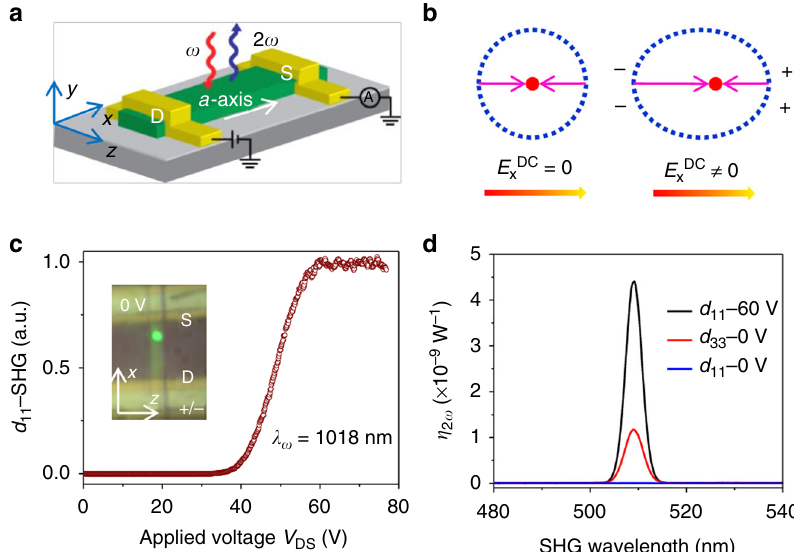
Fig. 1 Field-induced second-order nonlinear coef fi cient ( d 11 ) in a CdS nanobelt. a Schematic of a CdS nanobelt device with the source (S) and drain (D) electrodes. The long-axis of the nanobelt ( x -axis) is determined to be CdS a -axis, which is perpendicular to the z -axis (or CdS c -axis). The fundamental wave at the frequency of ω is normally incident upon the belt and excites the second-harmonic wave at 2 ω which is back-scattered. b Schematic of the response of the electron wave function to a strong d.c. applied fi eld. An atom with a positively charged nucleus (red dot) is surrounded by electron cloud (blue dots). If there is no external electric fi eld, the electron wave function is symmetric along the x -axis, which can be distorted by an external electric fi eld, thus turning on certain fi eld-induced second-order nonlinear coef fi cients. c Voltage-dependence of d 11 -SHG signal. Inset: device image when the fundamental wave (FW) is incident upon the CdS nanobelt near the source electrode (S). The S-electrode is grounded (0 V) and the drain electrode (D) is biased. When applying a positive bias ( V DS > 0), the electric current is along the x -axis (from D-electrode to S-electrode), with the reverse bias on the S- contact ( V DS > 0). d Normalized conversion ef fi ciency ( η 2 ω ¼ P 2 ω = P 2 ω ) of second-harmonic generation (SHG) resulting from different nonlinear coef fi cients ( d 11 and d 33 ) at different applied voltages ( V DS ), 0 and 60 V. In order to detect the d 11 -SHG signal, we focused the FW polarized along the x -axis ( I ω ,x )